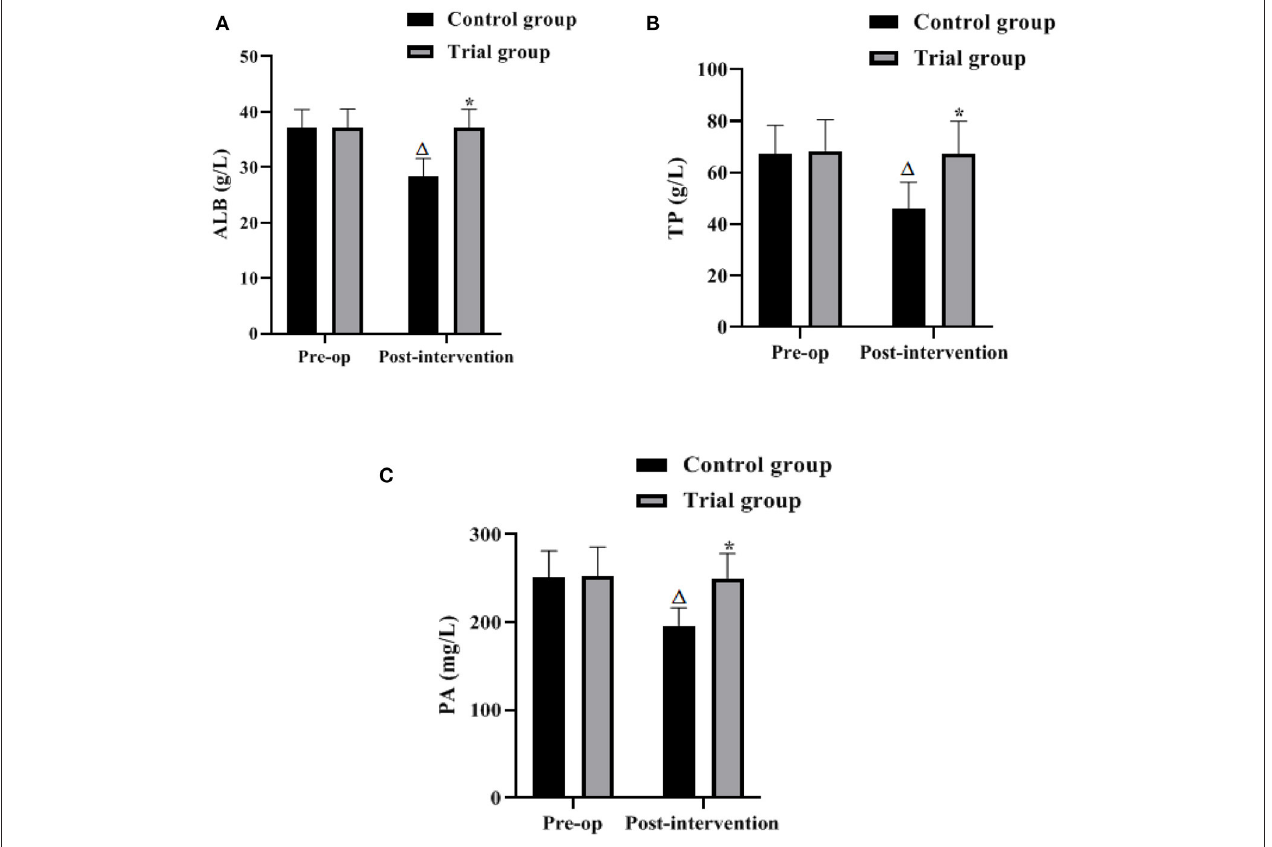
FIGURE 2 | Nutritional status of the 2 groups (Mean, SD). The contents in (A–C) are ALB, TP, and PA levels, respectively. Difference from the same group preoperatively 1 P < 0.05; difference between the two groups * P <